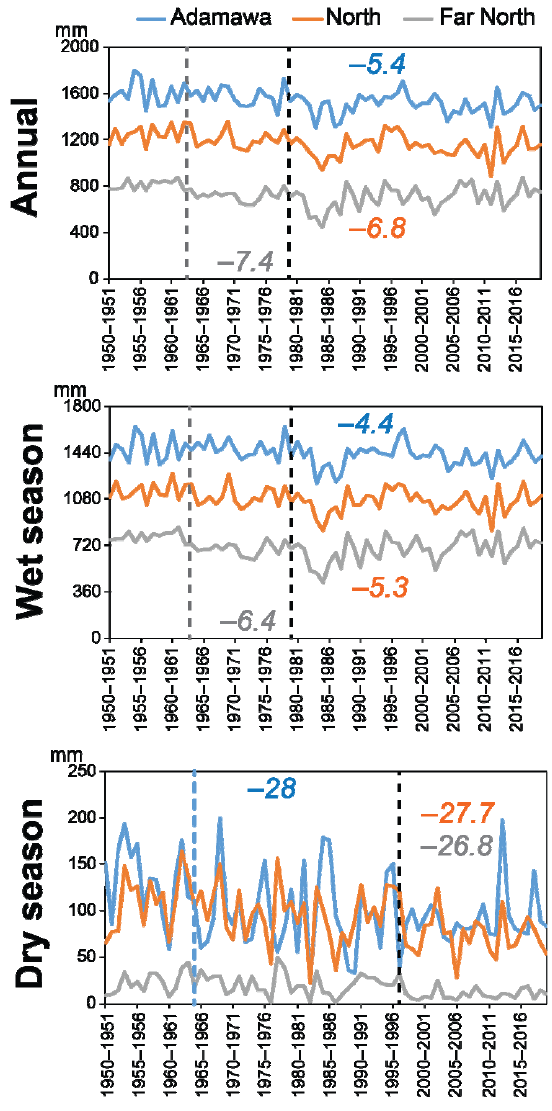
Figure 3. Temporal variation of annual and seasonal rainfall for the northern regions of the country (Adamawa, North and Far North), according to the Pettitt test. The rupture years are indicated by the vertical dashed lines. On their right sides appear the corresponding rates of change. The ruptures in black are those which are identical to several regions.